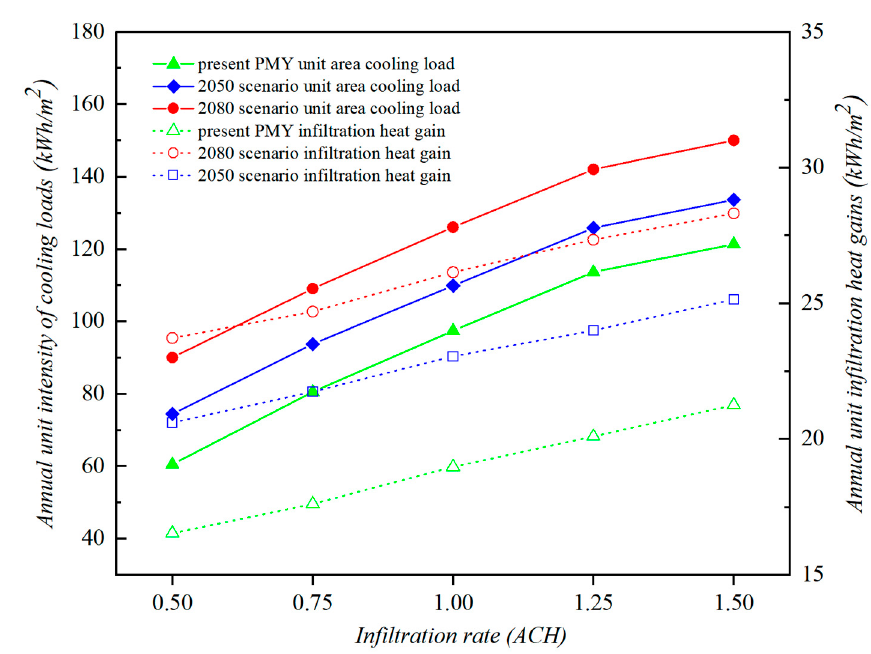
Figure 17. Annual unit intensity of cooling loads and unit infiltration heat gains due to various in- filtration rates of present TMY and predicted future scenarios (2050 and 2080). infiltration rates of present TMY and predicted future scenarios (2050 and